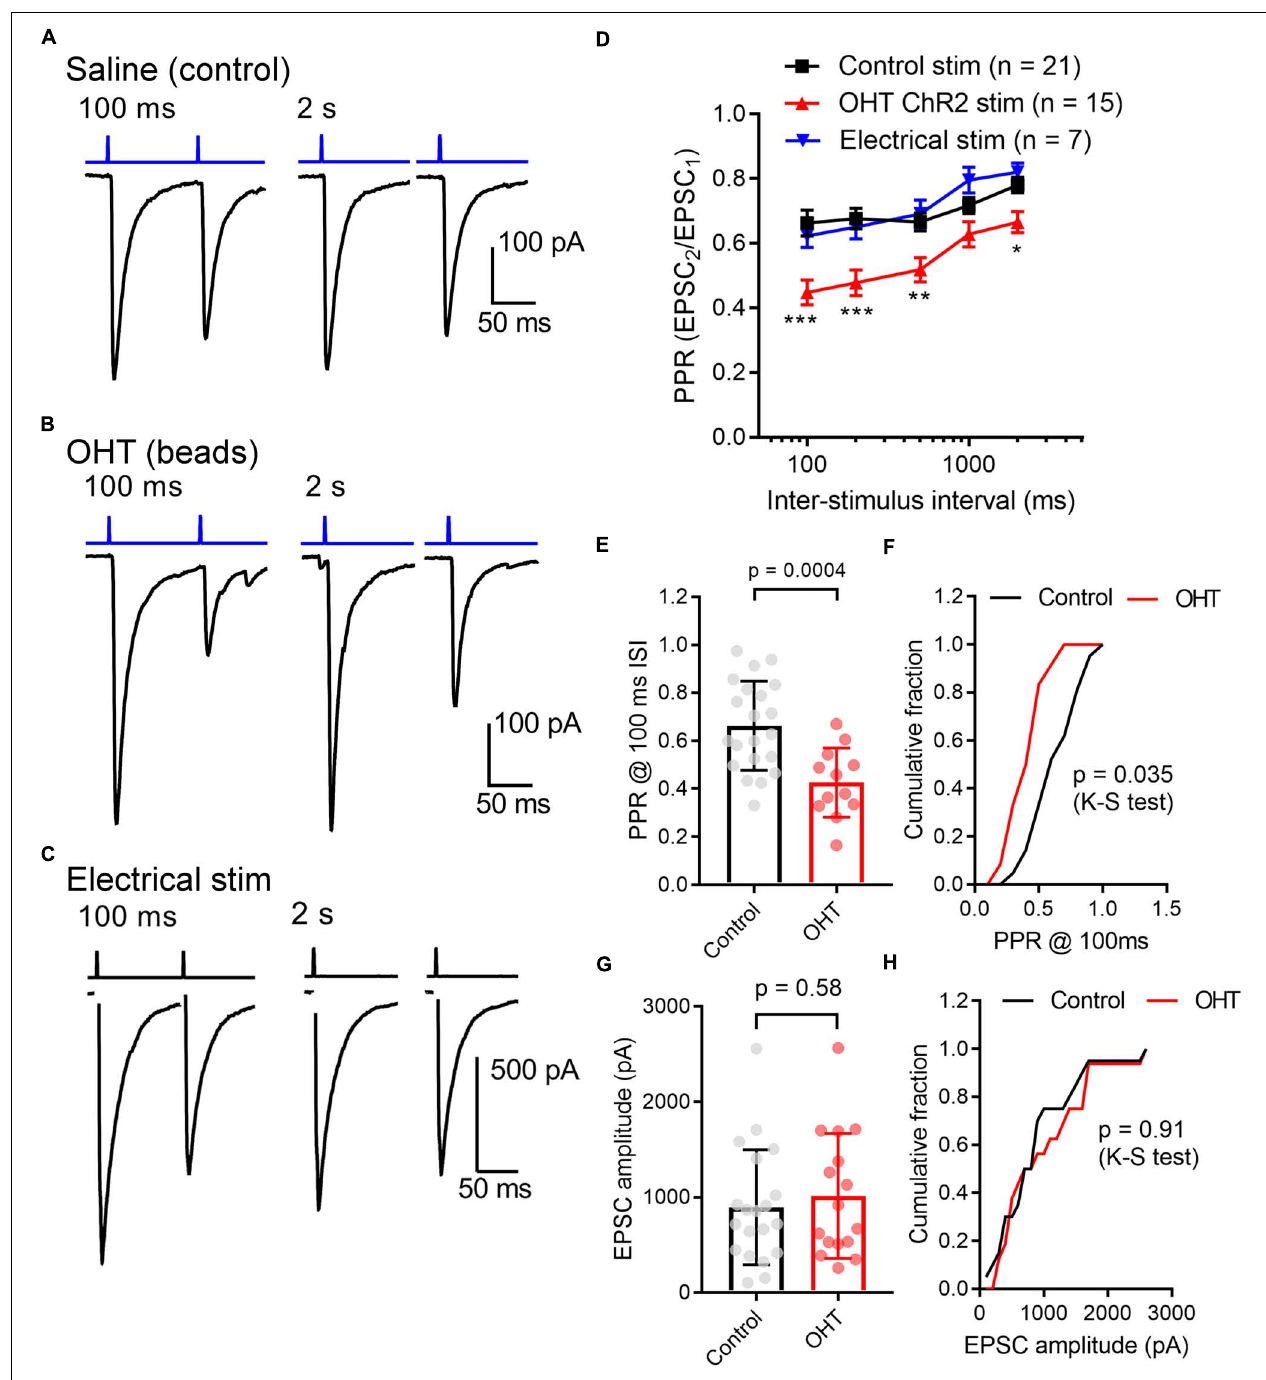
FIGURE 4 | Ocular hypertension increases synaptic depression at retinogeniculate synapses. (A) In brain slices from control animals, stimulation with a pair of 0.5 ms 460 nm LED flashes delivered through the microscope objective triggered post-synaptic currents displaying synaptic depression. In OHT (B) , depression was more pronounced. (C) Paired pulse experiment in which the optic tract was stimulated with an extracellular electrode in a parasagittal brain slice through the dLGN. The PPR was similar to the ChR2-evoked response in brain slices from saline-injected (control mice). The stimulus artifact was deleted for display. (D) The paired pulse ratio (EPSC2/EPSC1) plotted against stimulus interval showed that although PPR increased with increasing stimulus interval, it was lower in bead-injected OHT mice than in controls. PPR values recorded in response to electrical stimulation of the optic tract in parasagittal slices are shown for comparison. Unpaired t -test was used to compare PPR from control and OHT mouse brain slices. ∗∗ p < 0.005, ∗∗∗ p < 0.001, ∗ p < 0.01. (E,F) The paired pulse ratio measured at a 100-ms interval was lower in OHT brain slices relative to controls. (G,H) There was no significant difference in the EPSC amplitude evoked by a saturating (1.5 mW) LED stimulus. Values are plotted for each individual cell in (E,G) and the bar graphs represent mean + standard deviation.